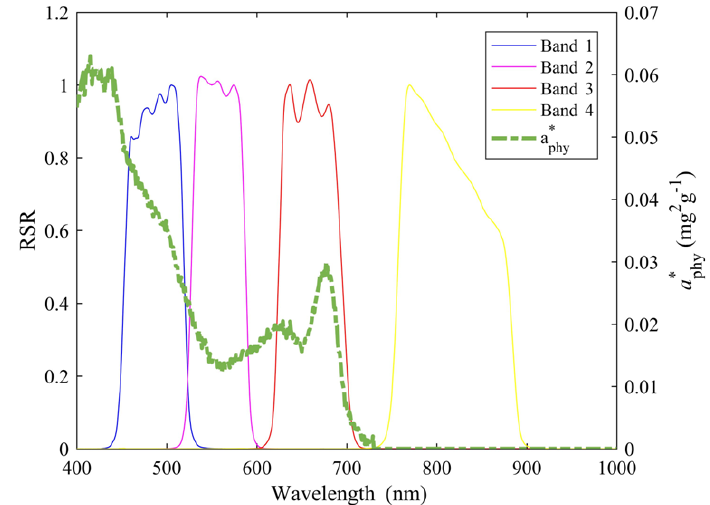
Figure A1. The relative spectral response function (RSRF) of the SPOT6 and spectral absorption coefficient of chlorophyll-a (a phy *) measured by in situ samples.